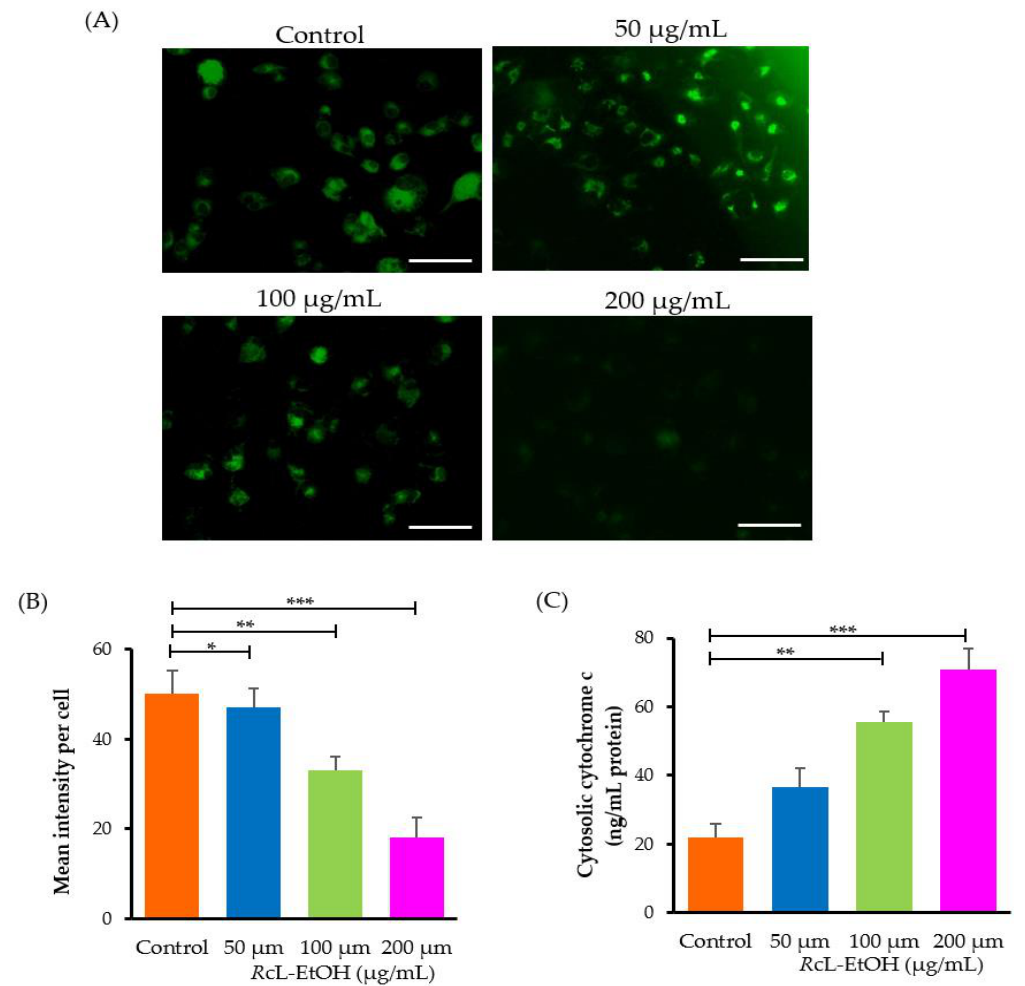
Figure 3. ( A ) Photomicrographs depicting the dissipation of ΔΨm within A549 cells post -treatment with varying concentrations (50, 100 and 200 µg/mL) of R cL-EtOH. Scale bar = 100 µm. ( B ) Quanti- fication of mean fluorescence intensity. ( C ) Effect of R cL-EtOH on cytosolic cytochrome c. * p < 0.01, ** p < 0.01, *** p < 0.001 vs.